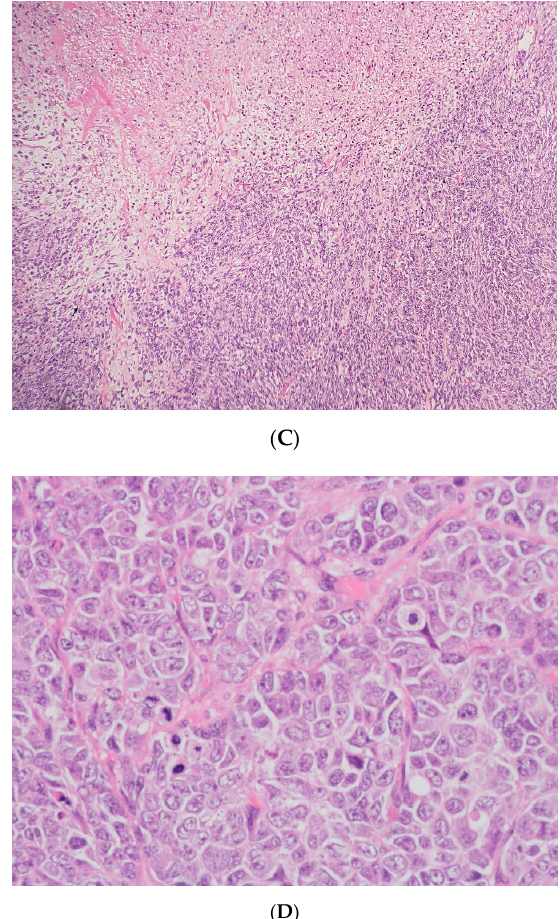
Figure 3. ( A ) The tumor cells are predominantly monomorphic and loosely cohesive with scant cytoplasm. ( B ) Small nests and individual tumor cells are separated by a fibrotic stroma. ( C ) A small cell component with nested growth and focal spindle morphology is juxtaposed to large cells with abundant eosinophilic cytoplasm. ( D ) The presence of areas of a more rhabdoid pattern are seen.